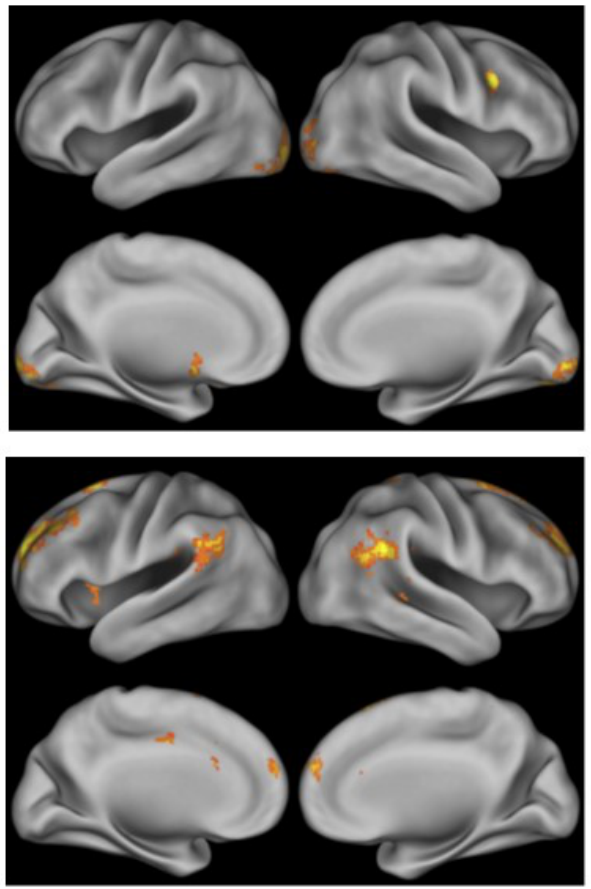
Figure 4 . Top. Whole-brain results from the contrast Correct Sparse-Dense Response > Uncertainty Response projected on an inflated lateral and medial cortical surface. Table 2 in Paul et al. (2015) listed the coordinates and number of voxels for every significant cluster. Images were cluster thresholded (correcting for multiple comparisons) at z > 3.54, p < .01. Bottom . Whole- brain results from the contrast Uncertainty Response > Correct Sparse-Dense Response projected on an inflated lateral and medial cortical surface. Table 3 in Paul et al. (2015) listed the coordinates and number of voxels for every significant cluster. Images were cluster thresholded (correcting for multiple comparisons) at z > 3.54, p < .01. From “Neural Networks of